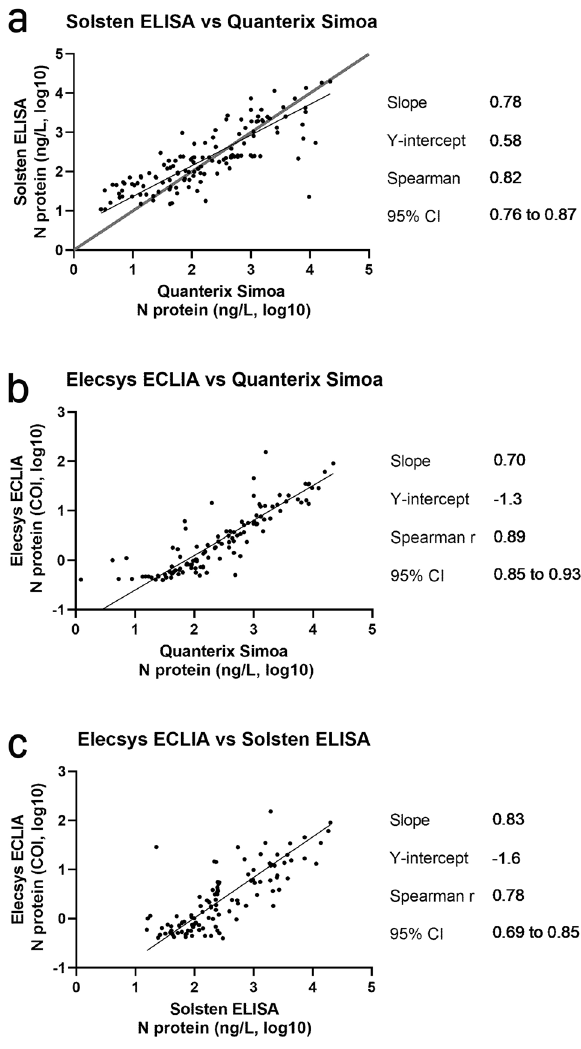
Figure 3. Pairwise assay comparisons of Solsten ELISA and Quanterix Simoa ( a ), Elecsys ECLIA and Quanterix Simoa ( b ) and Elecsys ECLIA and Solsten ELISA ( c